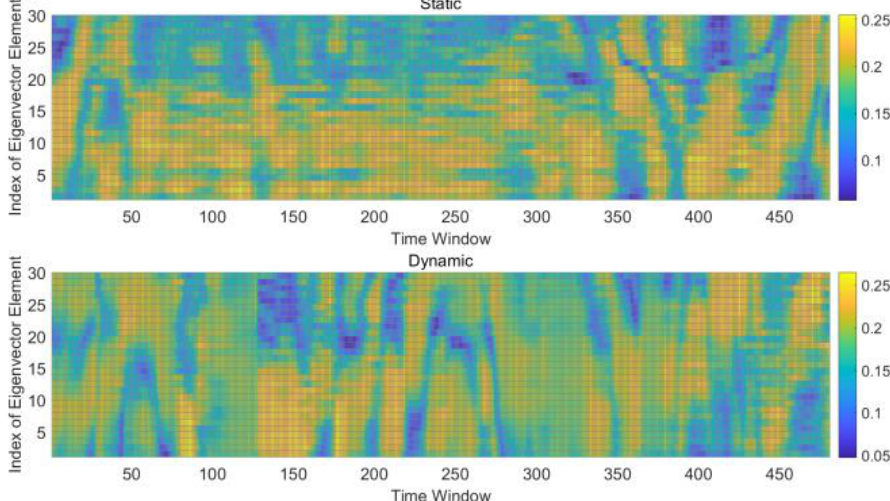
Figure 6. Comparison of distribution of eigenvectors.